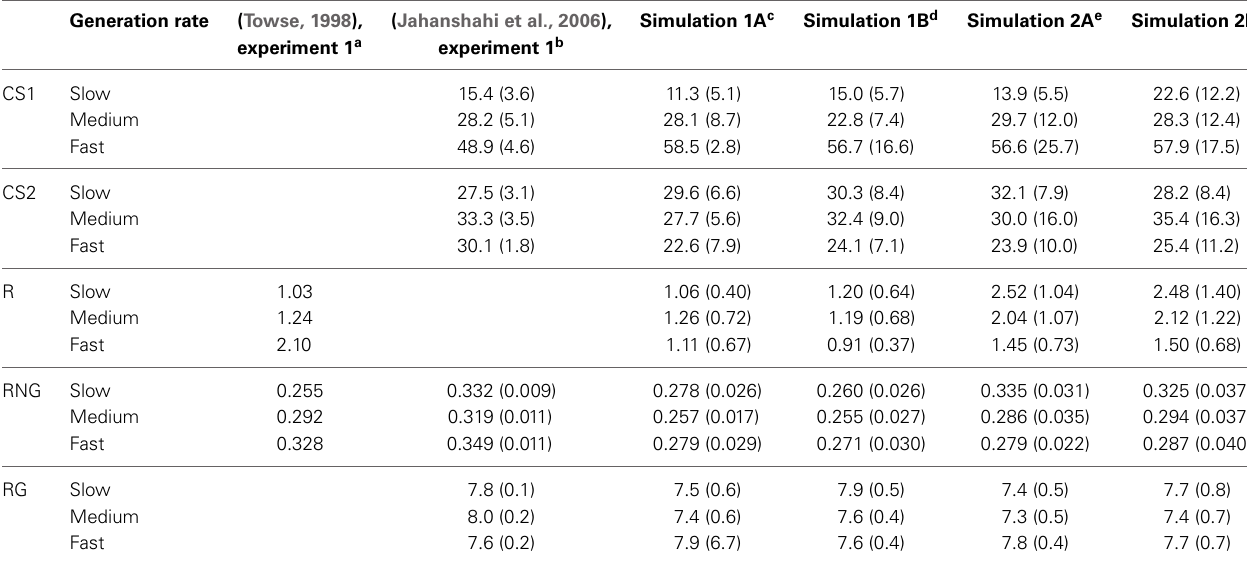
Table 2 | Mean and SD for all randomness indices, target data, and simulations. Generation